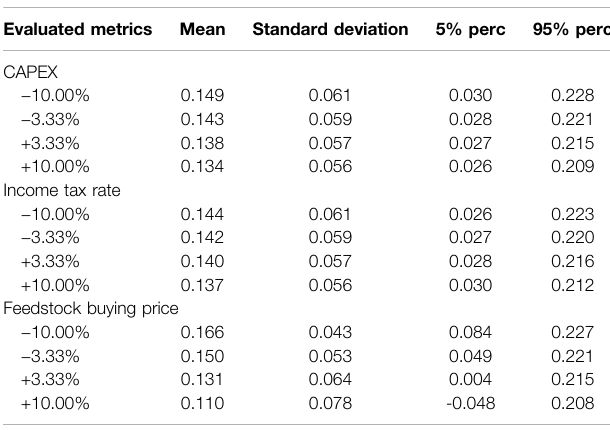
TABLE 4 | Stochastic sensitivity analysis of (cid:1) MIRR . Evaluated metrics Mean Standard deviation 5% perc 95% perc CAPEX − 10.00%